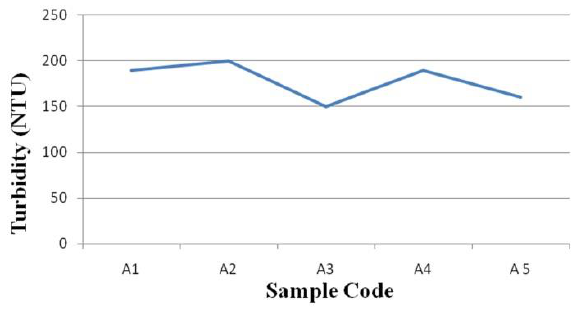
Figure 7. COD of